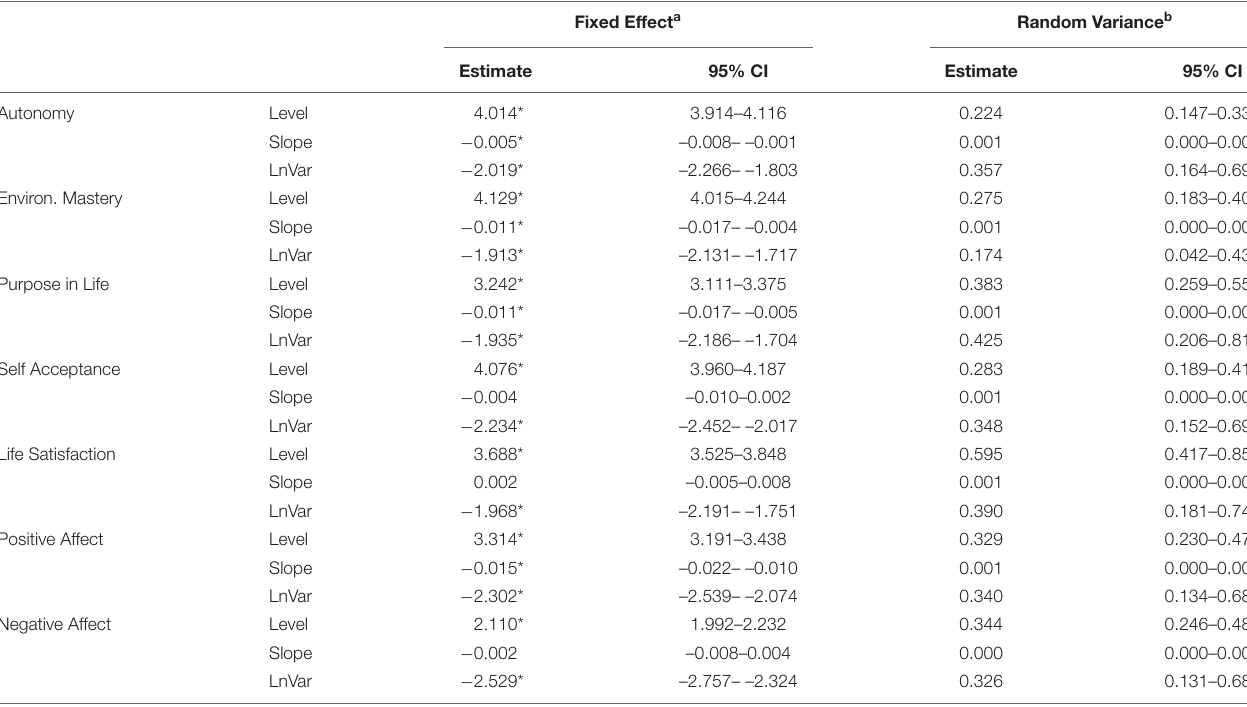
TABLE 6 | Within-person location-scale model estimates of the fixed effects and random variances of level, linear slope, and detrended variance of the wellbeing